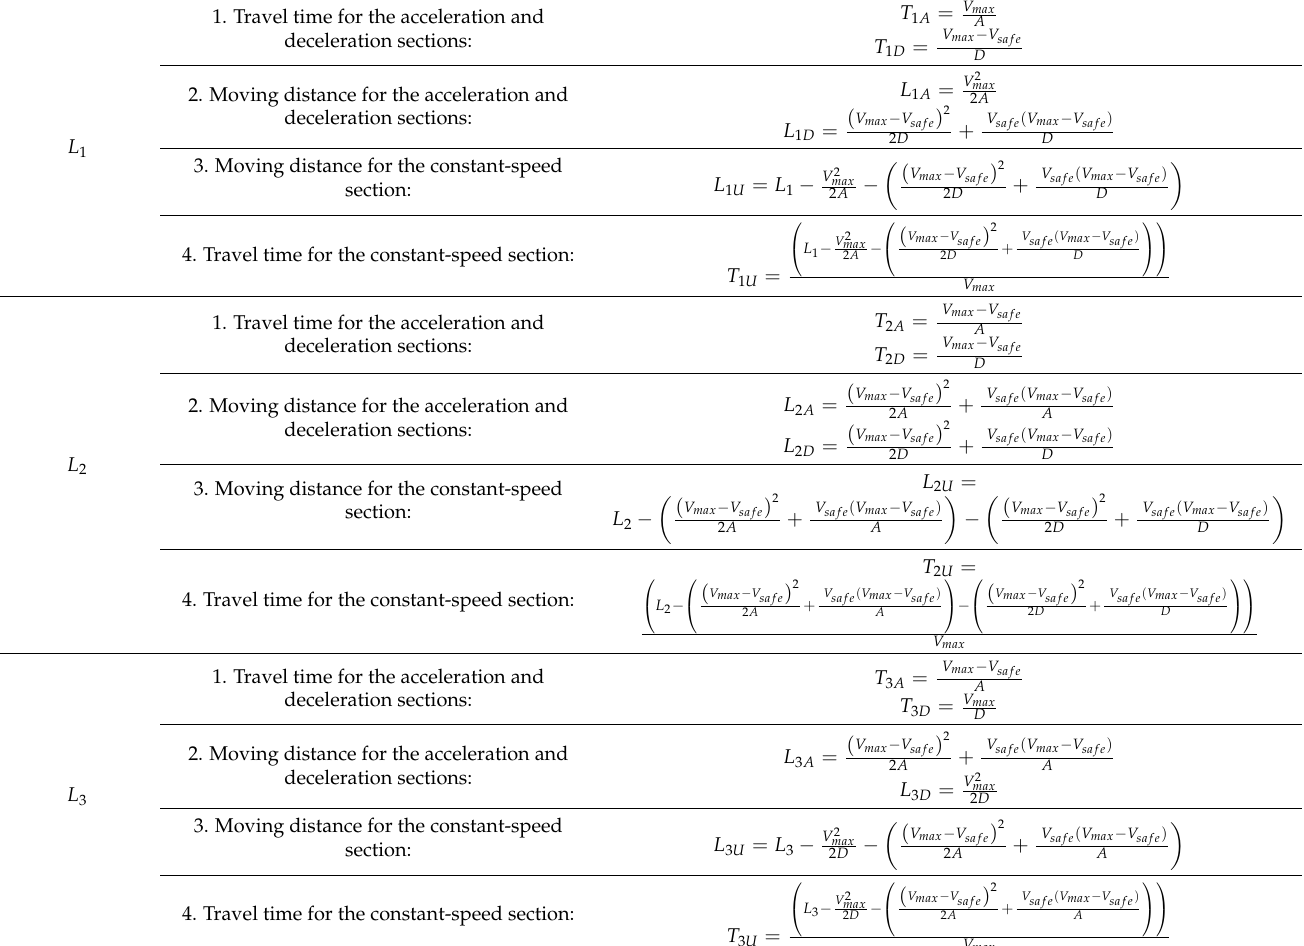
Table 2. Moving distance and travel time of the robot for the given example